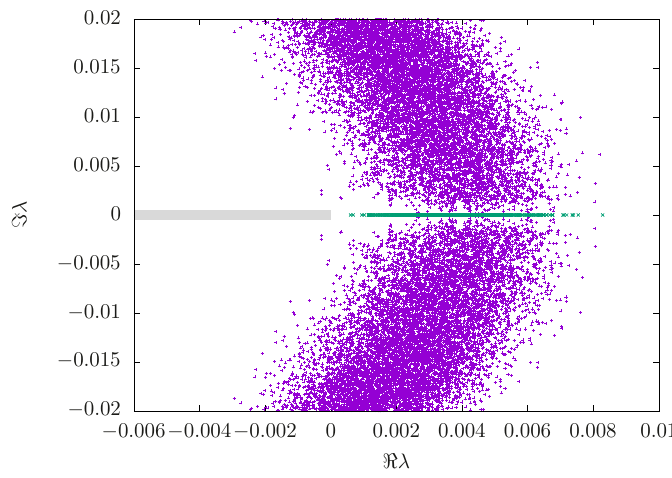
Figure 7. The eigenvalues of the Dirac-Wilson operator in the complex plane, relevant for the sign of the Pfaffian, from 1022 configurations at β = 5 . 5, κ = 0 . 1683. The green points indicate eigenvalues with a significant chirality of the eigenvector h v | γ 5 | v i > 0 . 001. Possible Pfaffian